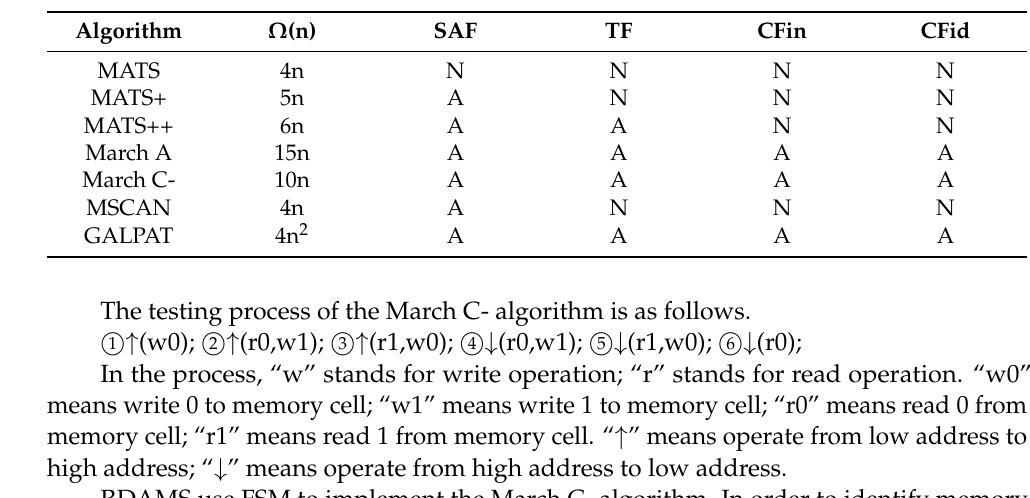
Table 2. Performance comparison of memory testing algorithms.